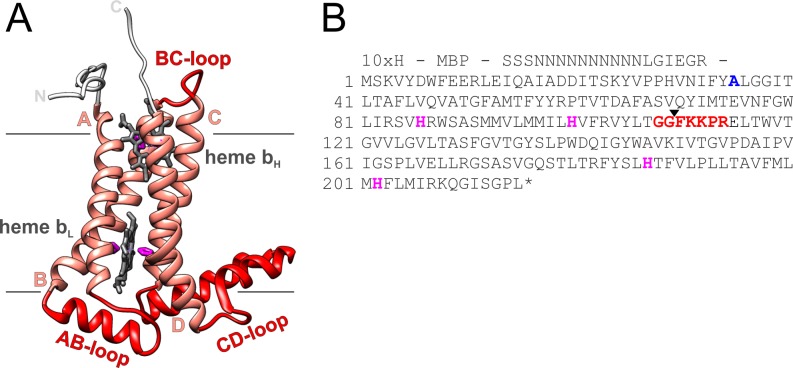
Structure (A) and amino acid sequence (B) of cyt. b6. (A) Cyt. b6 consists of four TM helices (A to D, in rose) that bind two heme molecules non-covalently (heme bH and heme bL, gray) via histidine residues (pink) located in helices B and D. Separated by the cofactors, cyt. b6 is composed of two halves, consisting of the helices A and B and the helices C and D, respectively. The ribbon presentation is oriented as viewed from the plane of the (thylakoid) membrane and with the side of the chloroplast stroma on top. Both, C- and N-terminus are facing the stroma. The interhelical loops (red) are located within the stroma (BC loop) as well as within the thylakoid lumen (AB loop and CD loop) (PDB-ID 1VF5 from [27]). (B) Amino acid sequence of cyt. b6 from Spinacia oleracea L (underlined) with a deca-histidine-tag and the maltose-binding protein (MBP) of E. coli fused to the N-terminus (indicated). Amino acids discussed in the text are highlighted in bold. Blue: Ala 35. Originally, there is a Cys at this position, which covalently binds a third heme (heme cn) in vivo. Hovewer, heme cn is not essential for the assembly of the b-type cytochrome [8]. Since we analyzed assembly of cyt. b6 by measuring the absorbance of the two non-covalently bound hemes bL and bH, we analyzed the C35A mutant and refer to it as “wt”. Pink: His 86, His 100, His 187 and His 202. These residues serve as axial ligands for the two non-covalent bound hemes. Red: Gly 108 to Arg 114. These amino acids form the BC-loop. To unravel the role of this loop, the BC-loop was elongated by five or ten Gly residues between Pro 113 and Arg 114. The black arrow between Gly 109 and Phe 110 highlights the boundaries of cf-cyt. b6-AB and cf-cyt. b6-CD.